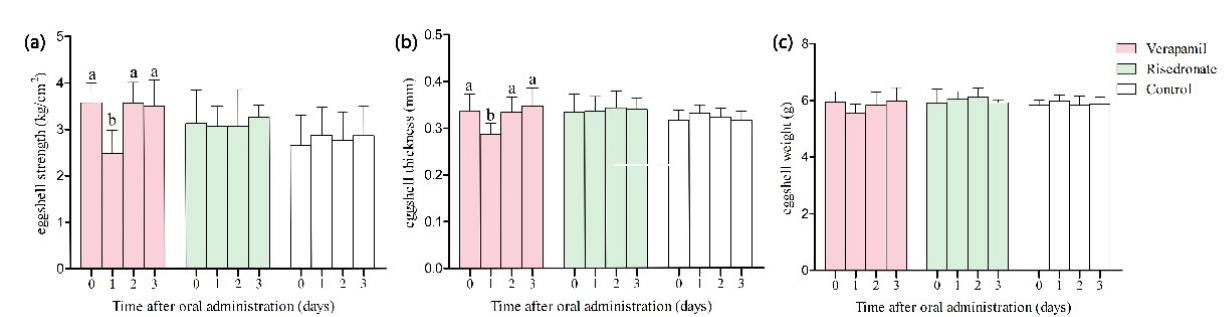
Figure 3. Effect of oral administration of verapamil and risedronate on eggshell quality, including ( a ) strength, ( b ) thickness, and ( c ) weight. The White Leghorn hens were fed verapamil hydrochloride (8 mg/hen), sodium risedronate (1.75 mg/hen), and empty capsules, respectively. Eggs were collected on the day capsules were fed and on the successive 3 days after oral administration, and then eggshell quality was measured. Data are represented as means ± SEM (n = 10 hens per group). Statistical significance of mean differences was tested by one-way ANOVA. p < 0.05 (a,b).